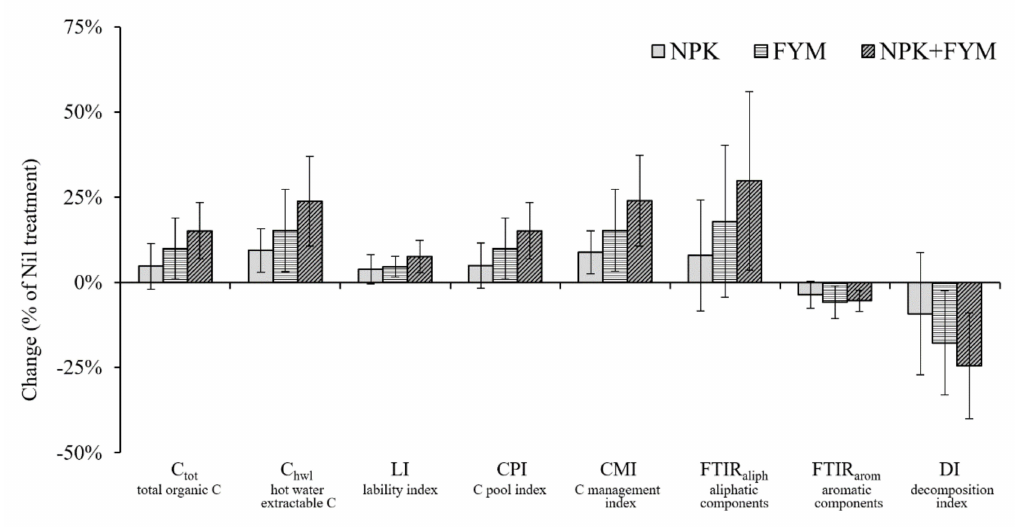
Figure 2. Change of soil organic matter parameters and indices related to unfertilized control treatment (averages of all experiments). Bars signify the standard